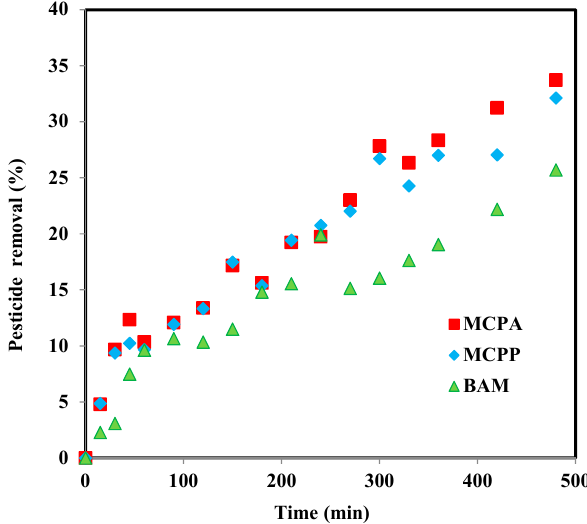
Figure 6. Pesticides removal utilizing a 3D-NCPEs system at maximum synergy voltage (5 V).